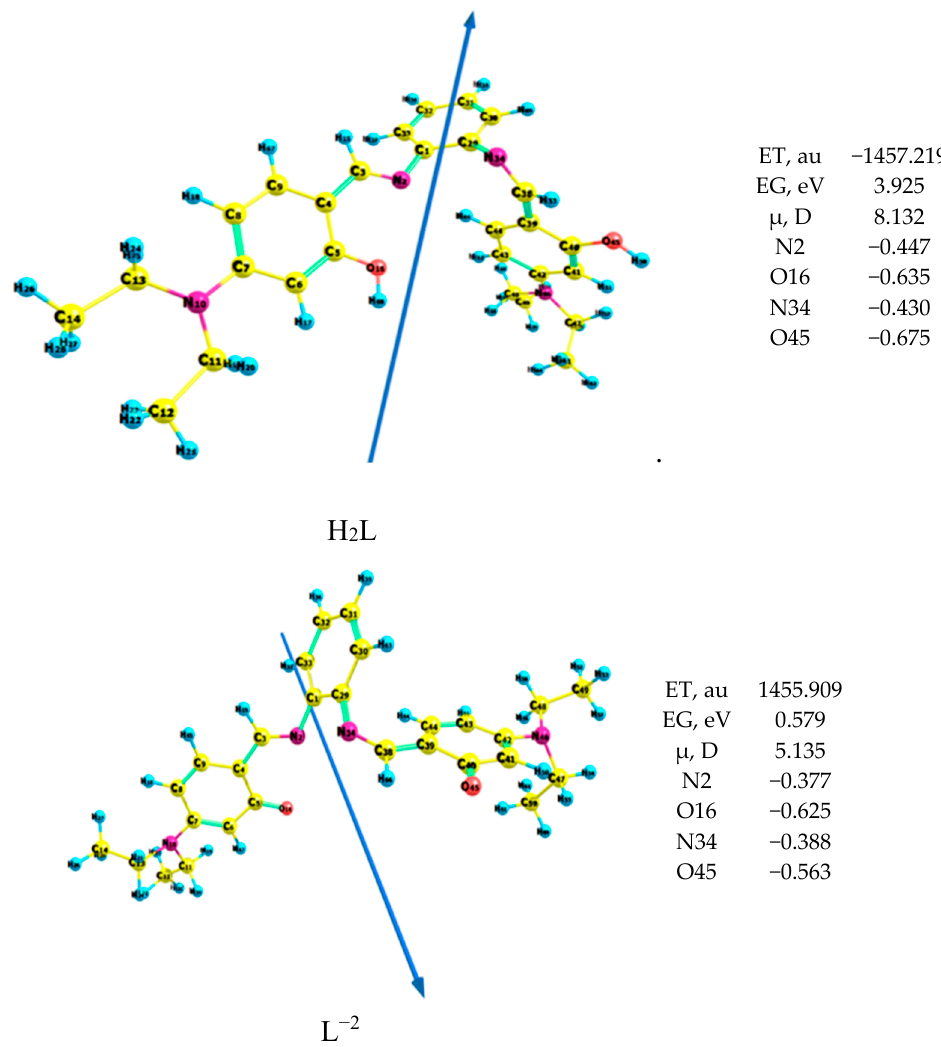
Figure 3. Geometry of the ligand of the H 2 L ligand and its anion L 2 − .